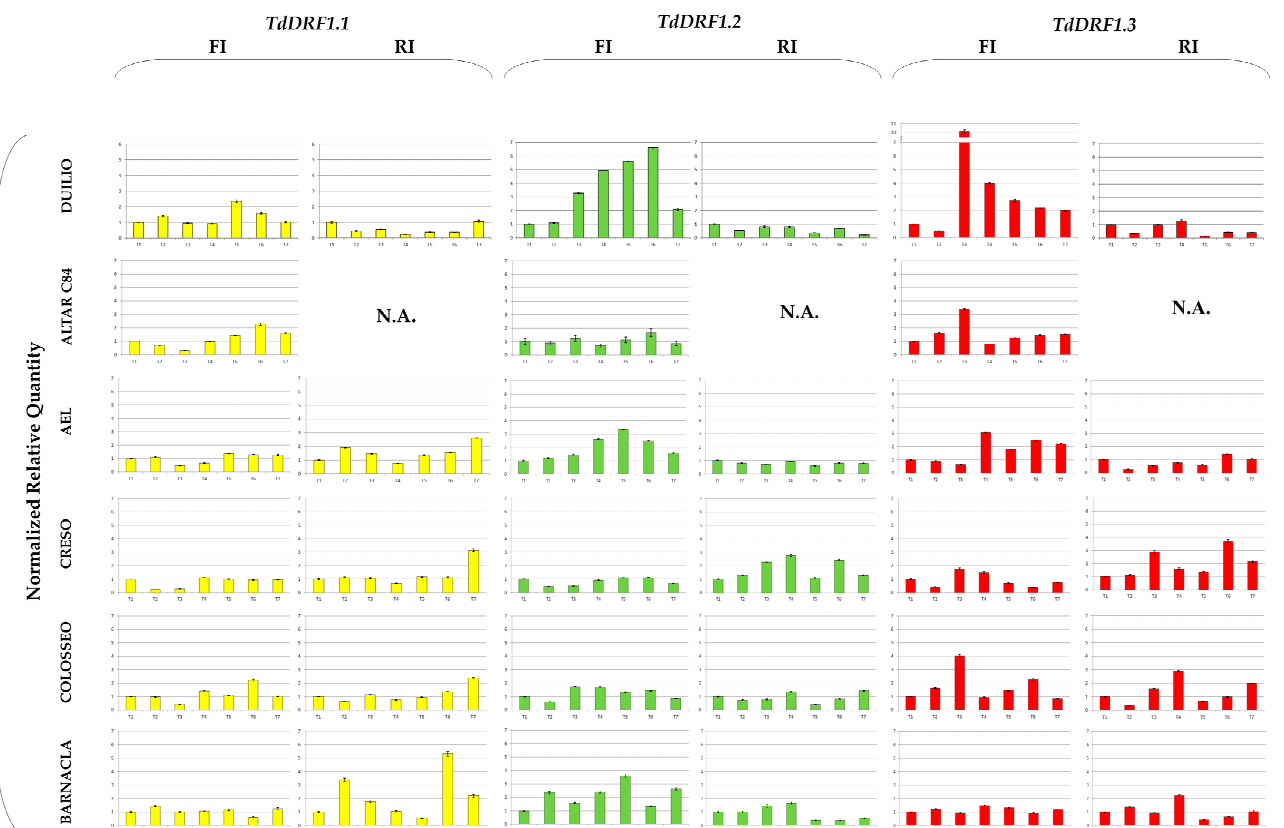
Figure 1. Expression profiles of the TdDRF1 gene transcripts. Each expression profile is shown as normalized relative quantity rescaled to its own T1 value. Results referred to the six durum wheat genotypes analysed under both FI and RI conditions ( TdDRF1.1 in yellow, TdDRF1.2 in green and TdDRF1.3 in red, respectively). The time course consisted of seven points (T1 to T7). N.A., data not available. Data are represented as mean + SE.